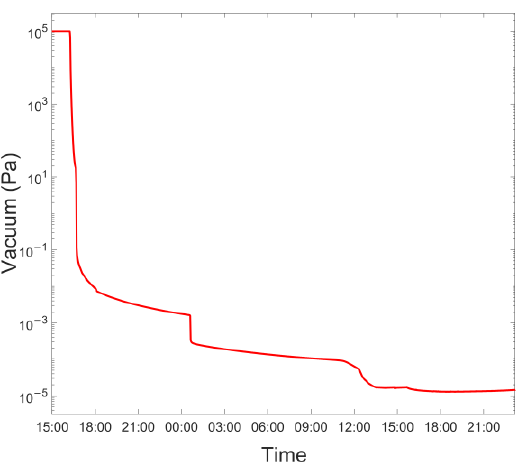
Figure 6. The temporal evolution curve of the vacuum degree in the facility.